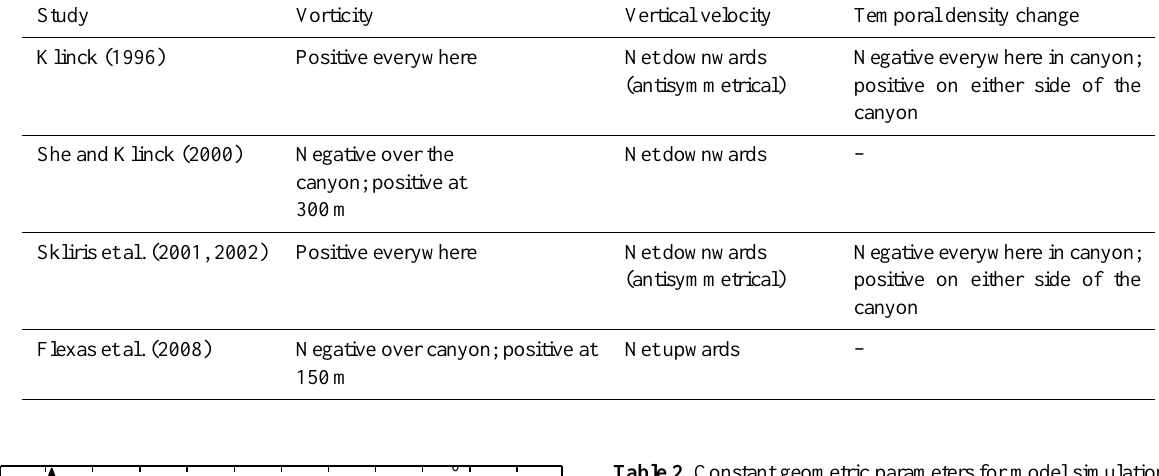
Table 2. Constant geometric parameters for model